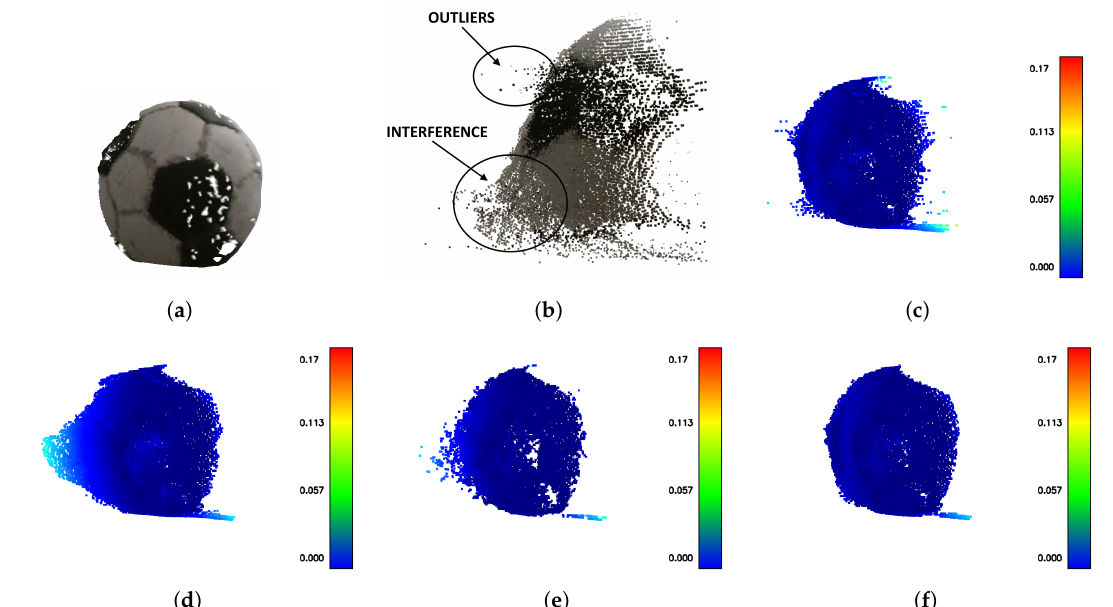
Figure 15. The visualizations of distances for IMBM, SOR and ROR filters. All the results are for buffer size 5. ( a ) The reference (the ball). ( b ) The difference between outliers and interference in the corrupted point cloud. ( c ) The IMBM filter sufficently suppresses the interference but outliers remain. ( d ) The SOR filtered point cloud does not contain outliers but intereference still remains. ( e ) The ROR filtered point cloud does not contain outliers but intereference still remains. ( f ) The best result using SOR and IMBM filter applied subsequently.